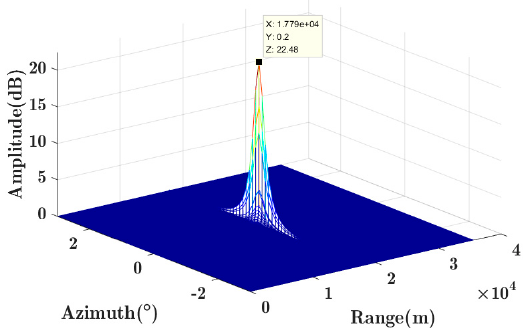
Figure 7. Sparse reconstruction of the target.